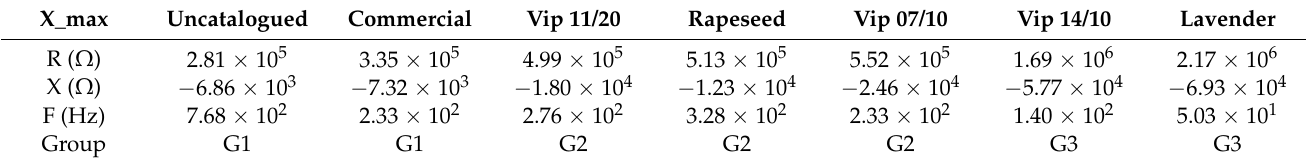
Table 5. Characteristic values at maximum reactance (less